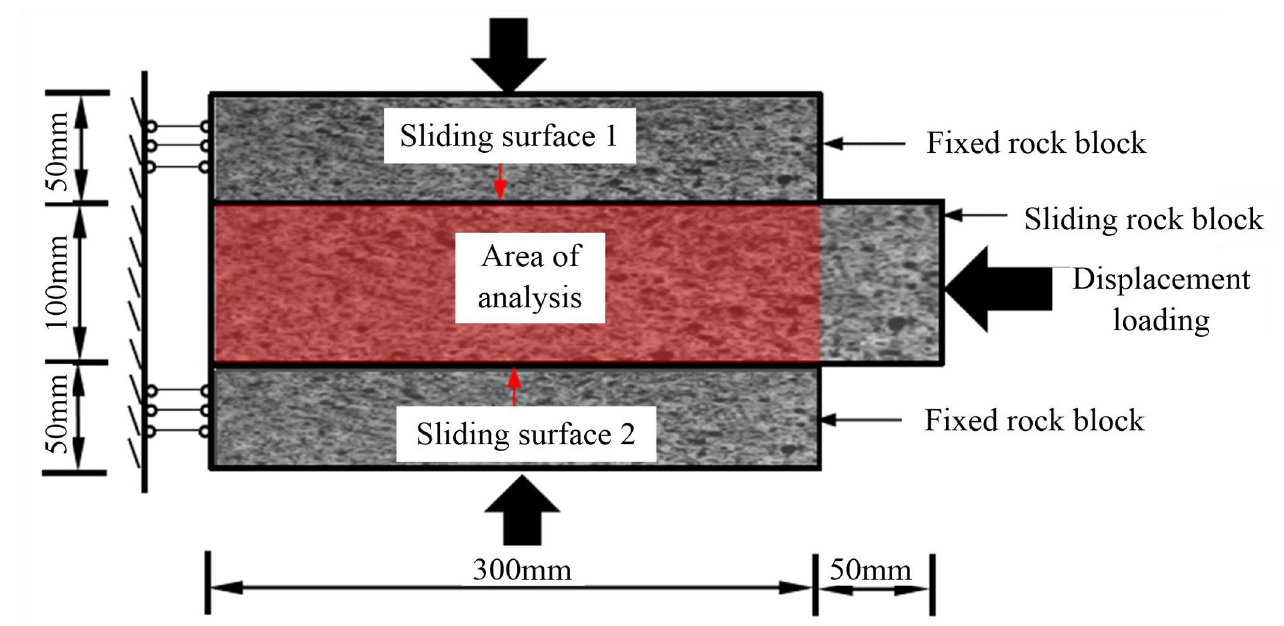
Fig 1. Experimental model and specimen